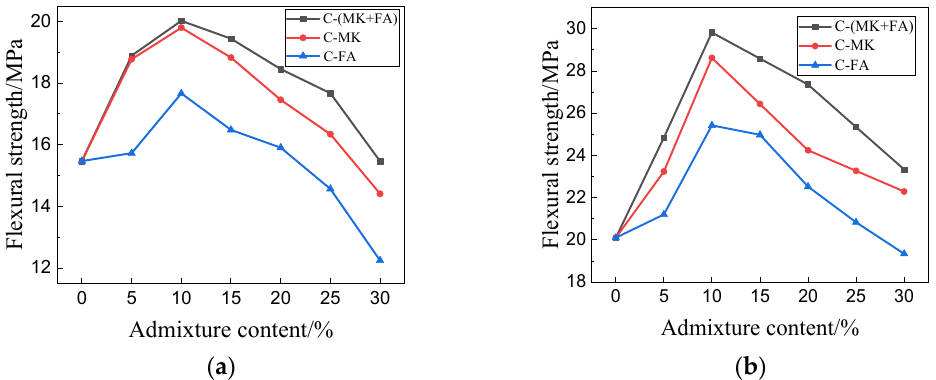
( b ) Figure 4. Compressive strength of hardened MOSC after different curing durations: ( a ) 3 days; ( b ) 28 days. Figure 5 shows the flexural strength of MOSC samples cured for different durations. The general trend observed in the flexural strength was identical to that observed in the compressive strength (Figure 4). As the MK and FA portion increased, the flexural strength initially increased, and then decreased. At 10% admixture content, the C- (MK+FA) sample exhibited the greatest maximum flexural strength, followed by C-MK and C-FA, at 29.82 MPa, 28.62 Mpa, and 25.42 MPa; in contrast to sample C, the flexural strength increased by 48.36%, 42.32%, and 26.41%, respectively. The improvement effect of FA and MK on the flexural strength of the system was better than that on the compres-